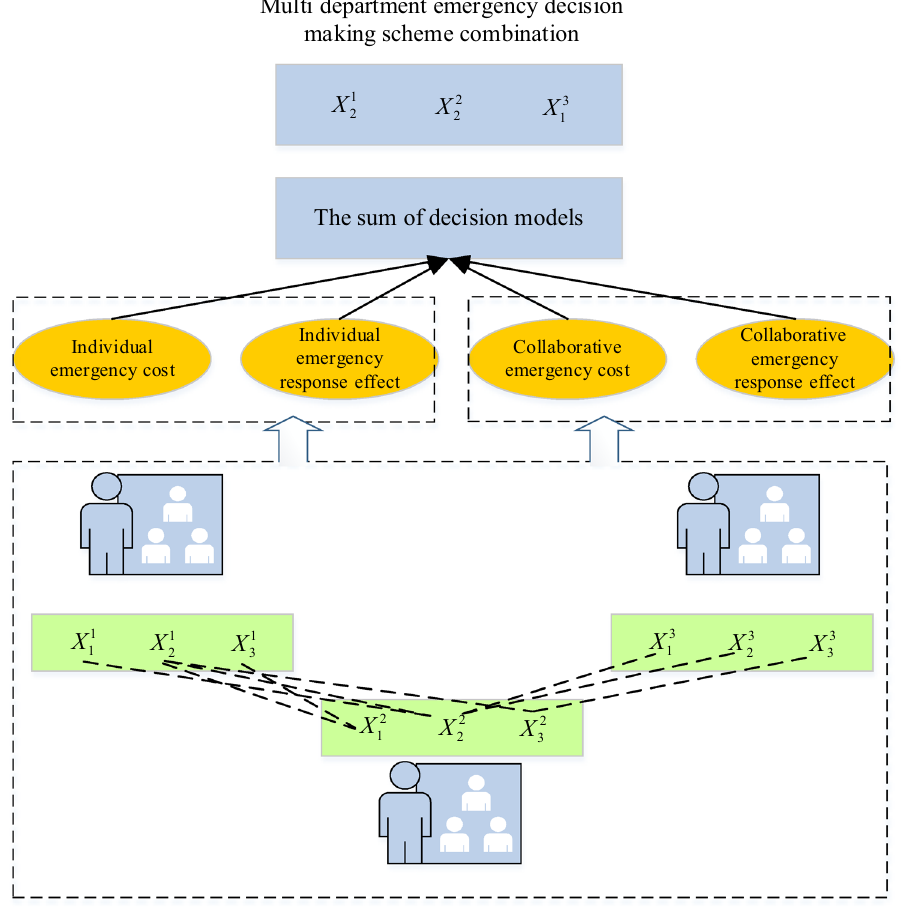
Figure 4. Selection process of multi-department emergency